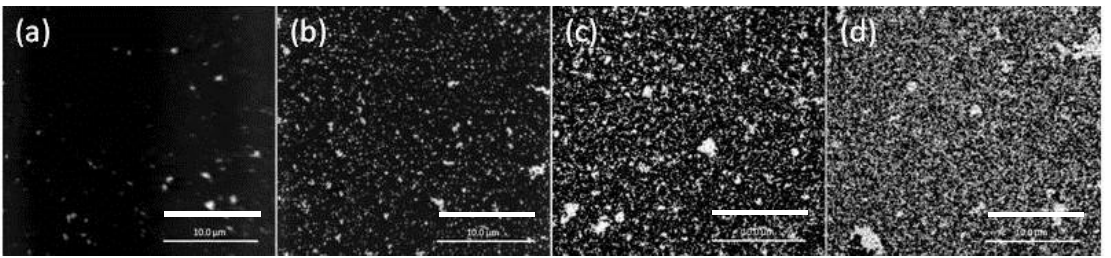
Figure 5. SEM images of the surfaces of the PIMs with a “critical AuNP mass” for the following concentrations of Aliquat 336: ( a ) 20; ( b ) 25; ( c ) 30; and ( d ) 35 wt %. The white bars are equal to 10 μm.